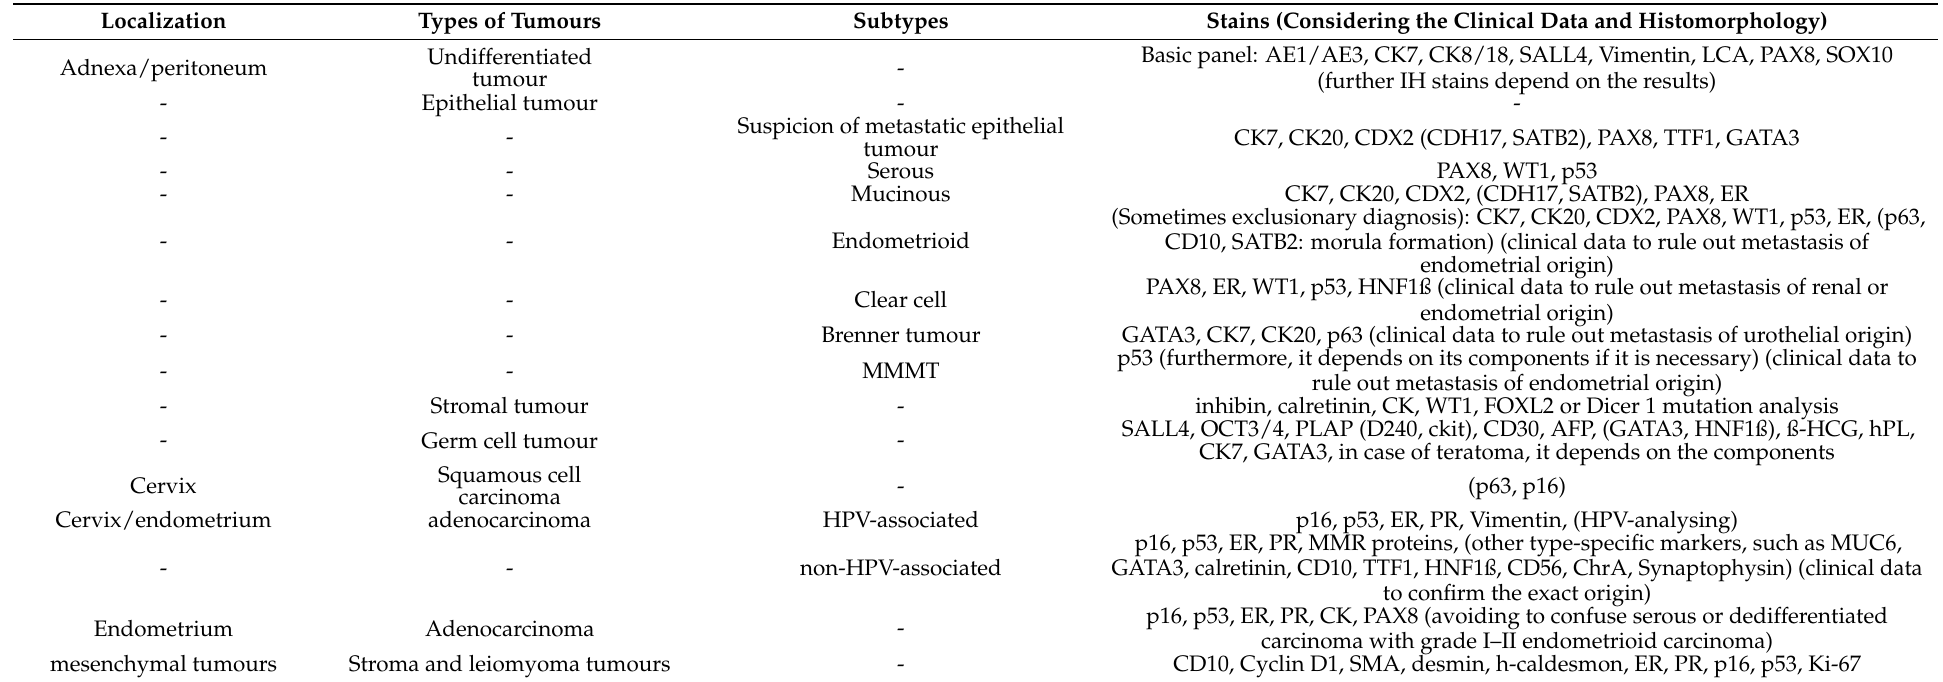
Table A1. Immunohistochemical stains used in gynaecological